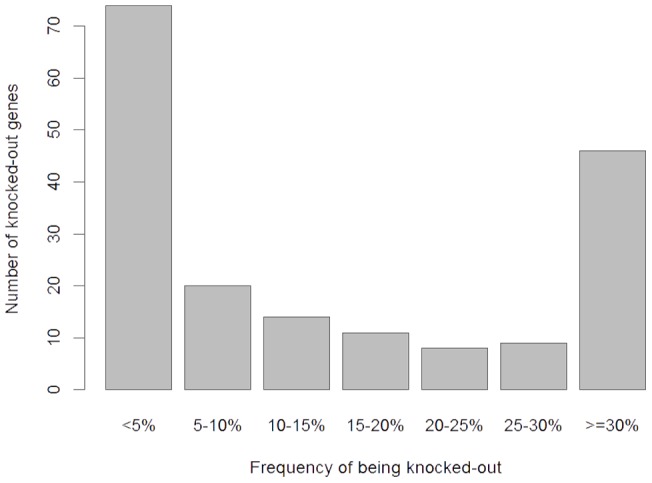
Identification of “knocked-out” genes.
A, Frequency spectrum of observed “knocked-out” genes. Genes containing homozygous LoF variants were expected to be silent or knocked-out. Numbers of “knocked-out” genes were counted with respect to the frequency of “knock-out” occurrence in the 44 genomes.